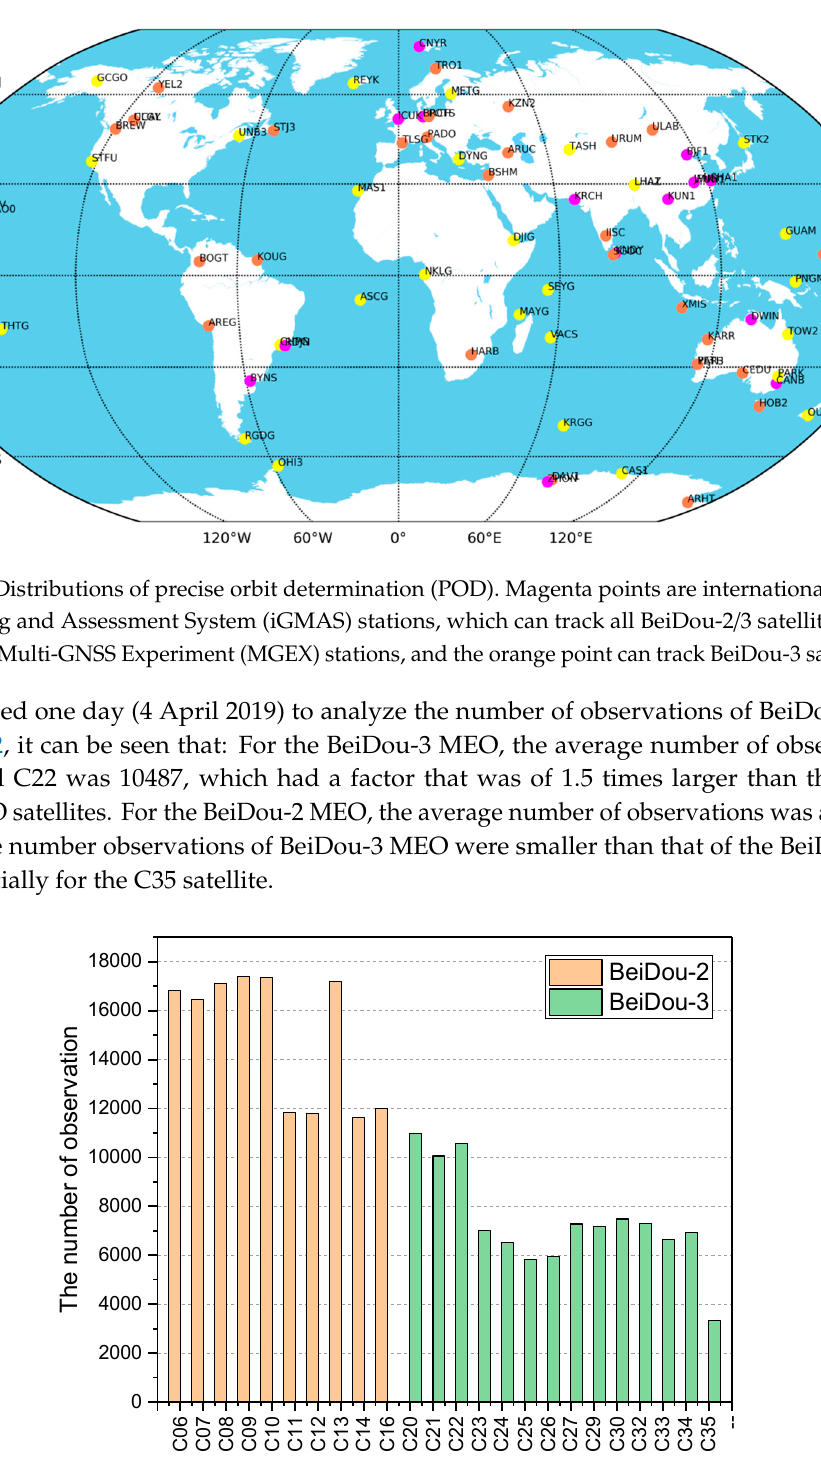
Figure 2. The number of observations of BeiDou-2 and BeiDou-3 satellites (4 April 2019). Brown bars are numbers for BeiDou-2 Inclined Geosynchronous Orbit (IGSO) and Medium Earth Orbit (MEO) satellites. Green bars are for BeiDou-3 MEO satellites.